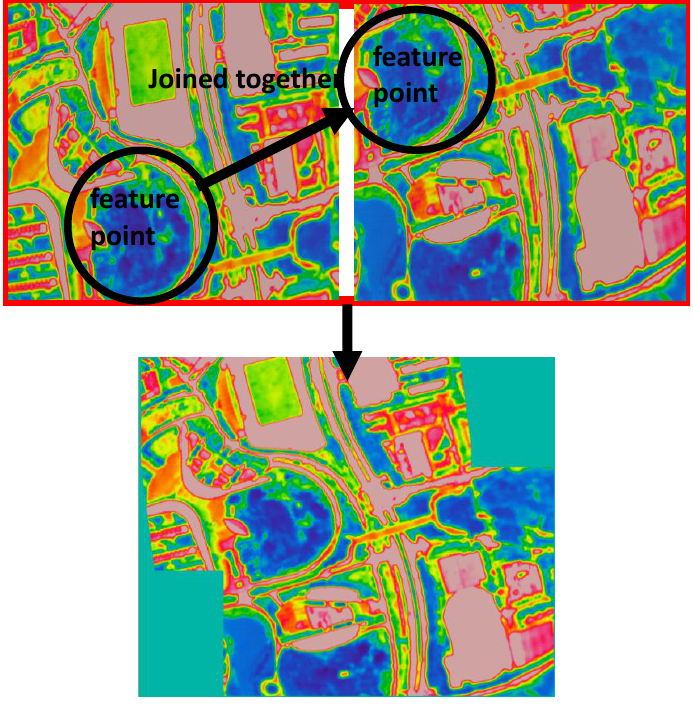
Figure 8. Adjacent images matching